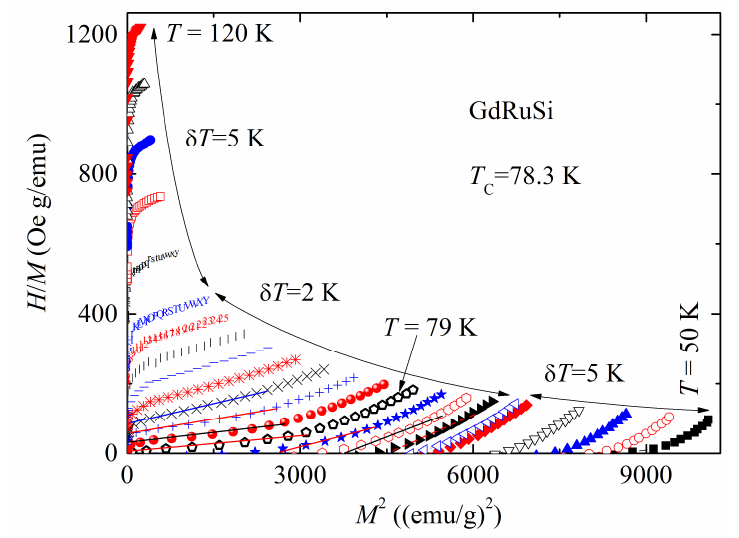
Figure 3. Arrot plots for the GdRuSi compound. Different colors for different symbols are made to better distinguish them.